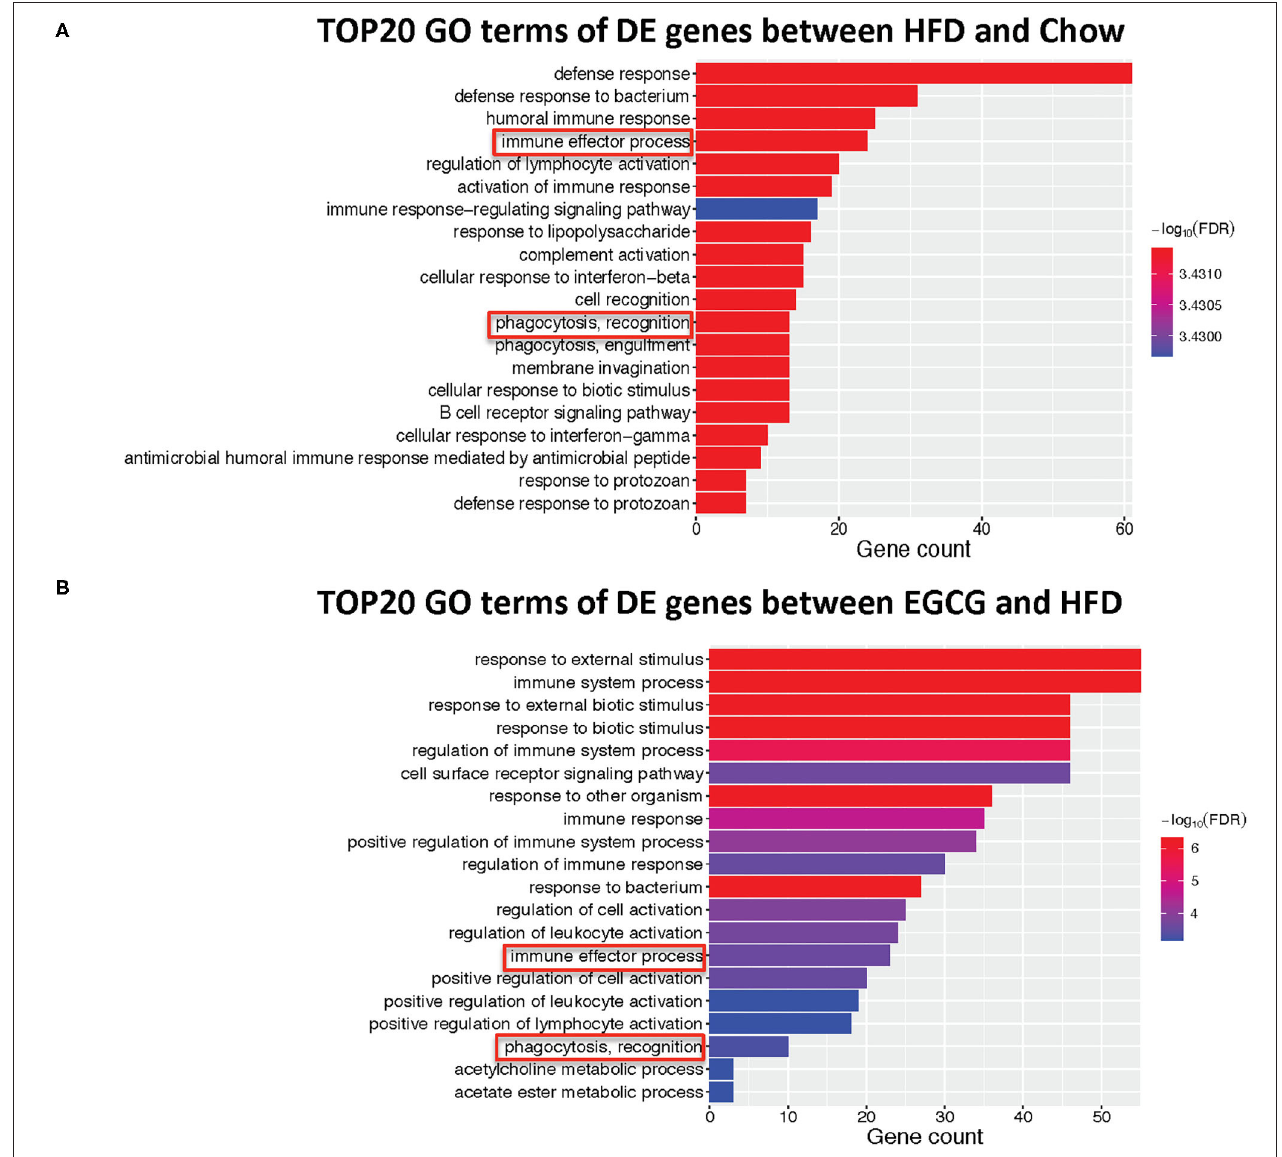
FIGURE 5 | Gene ontology enrichment analysis of differentially expressed genes. Top 20 GO terms with FDR < 0.05 in GO analysis: (A) HFD vs. Chow, (B) EGCG vs. HFD. The immune-related pathways were framed in